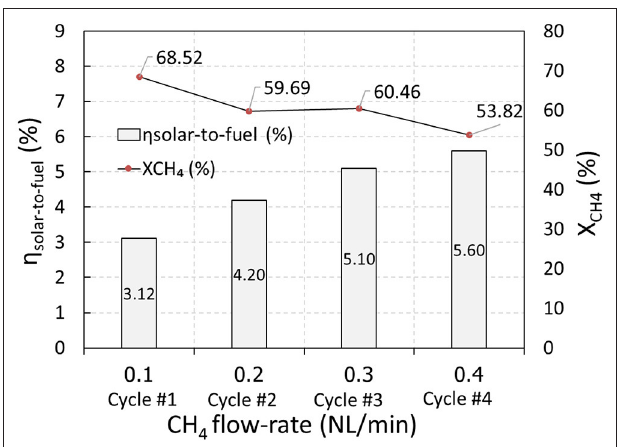
FIGURE 10 | CH 4 conversion and solar-to-fuel efficiency as a function of inlet CH 4 flow rate at 1,000 ◦ C.